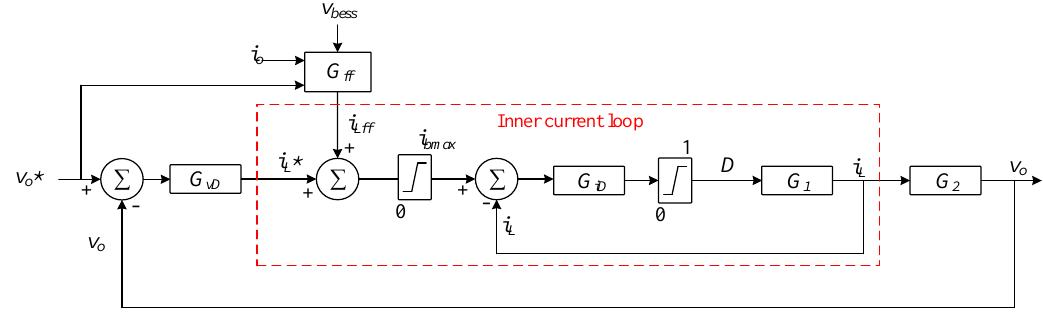
Figure 4. Schematic of DC/DC boost converter cascaded control configuration with feedforward loop.